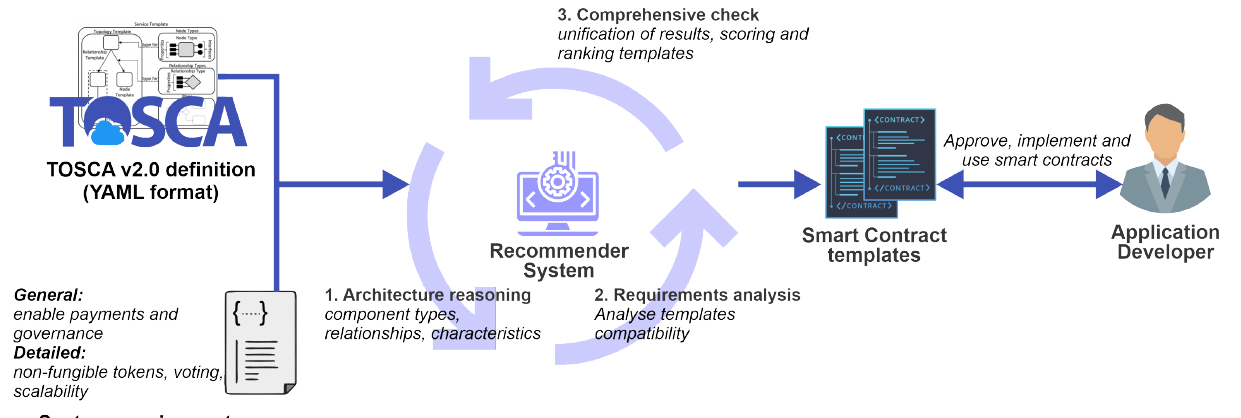
Figure 6. High-level architecture representing the pillar recommender system components with the main workflow.